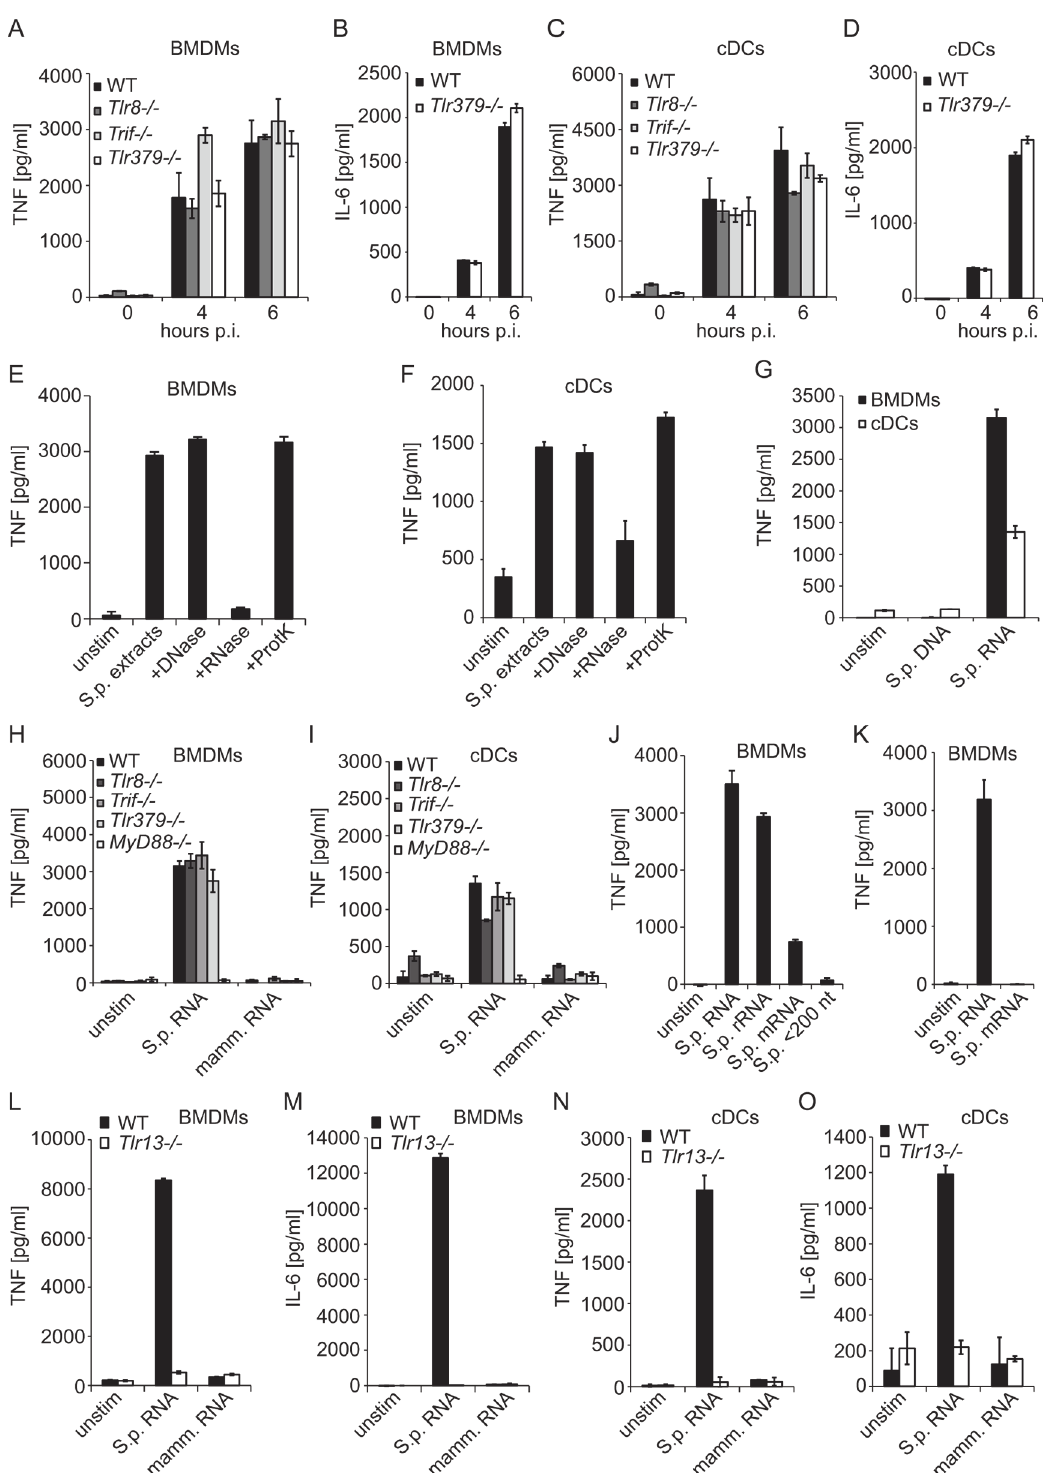
Fig 1. S . pyogenes rRNA induces cytokine production in a TLR13-dependent way and independently of TRIF, TLR3, TLR7, TLR8 and TLR9. BMDMs (A, B) or cDCs (C, D) from Tlr8 − / − , Trif − / − or Tlr379 triple-deficient mice as well as control mice (WT) were infected with S . pyogenes (MOI = 50) or left uninfected. At indicated time points, supernatants were collected and TNF (A, C) or IL-6 (B, D) release was measured by ELISA. (E, F) S . pyogenes cells were sonicated and the extracts were treated with either DNase I, RNase A, proteinase K, or left untreated (control extract). These extracts were delivered